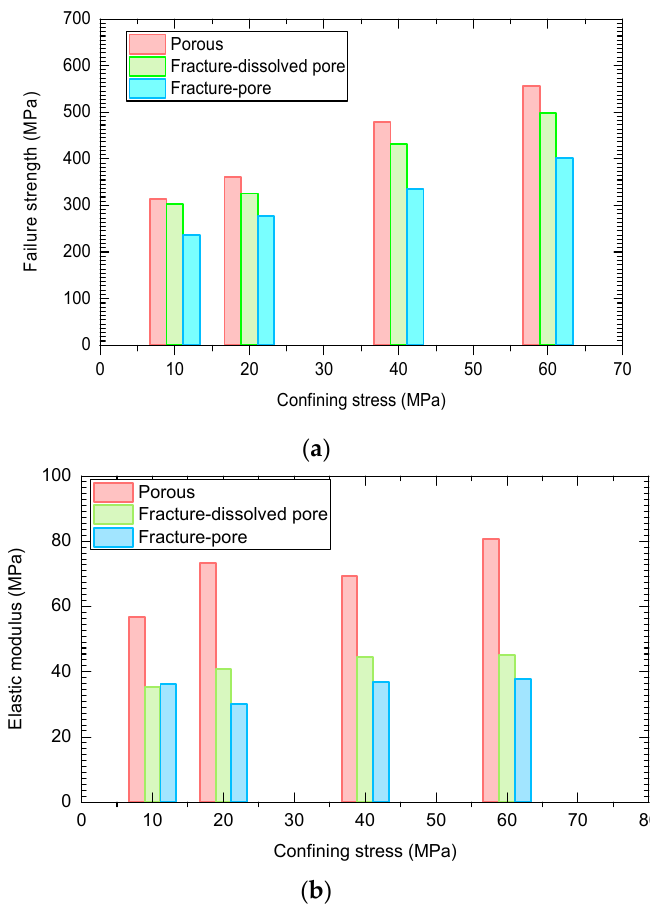
Figure 3. Mechanical behavior of rock samples with different reservoir spaces under triaxial com- pression conditions: ( a ) failure strength; ( b ) Elastic modulus.